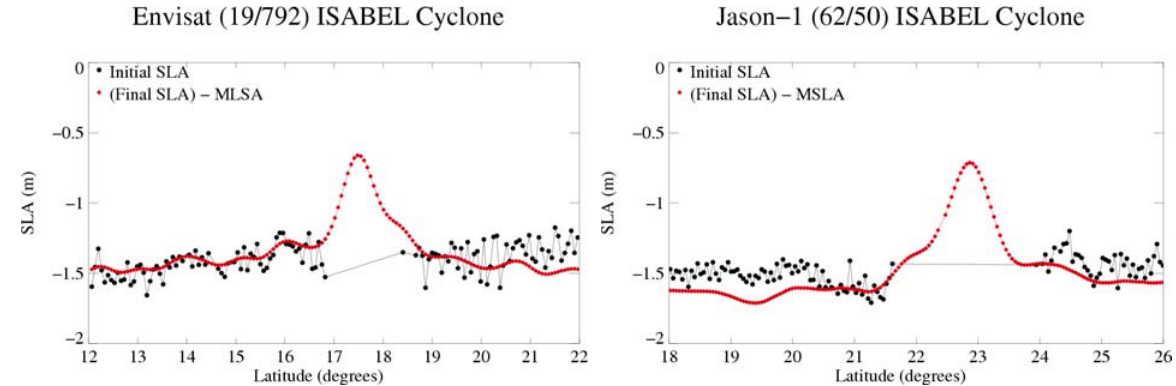
Figure 10. Initial and final SLA computed for Envisat (cycle 19, track 792) and Jason-1 (cycle 62, track 50) during Tropical Cyclone